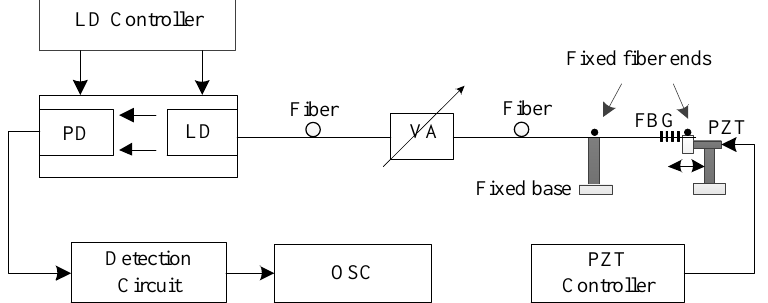
Figure 4. Experimental FBG–SMI system for verifying the proposed model: LD, laser diode; PD, photodiode; VA, variable attenuator; PZT, piezoelectric transducer; OSC, oscilloscope.